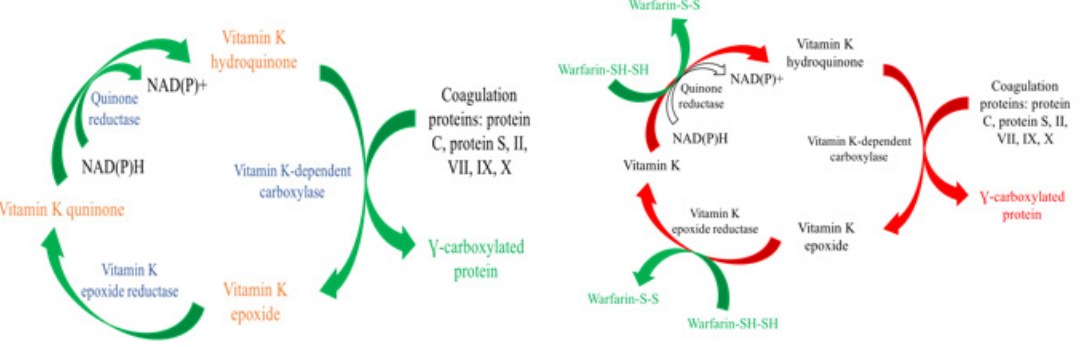
Figure 6. Normal Vitamin K cycle vs. Vitamin K antagonist. Compared to the normal pathway on the left, warfarin is reduced by Vitamin K epoxide reductase and quinone reductase preventing the regeneration of Vitamin K and subsequent carboxylation of coagulation factors.